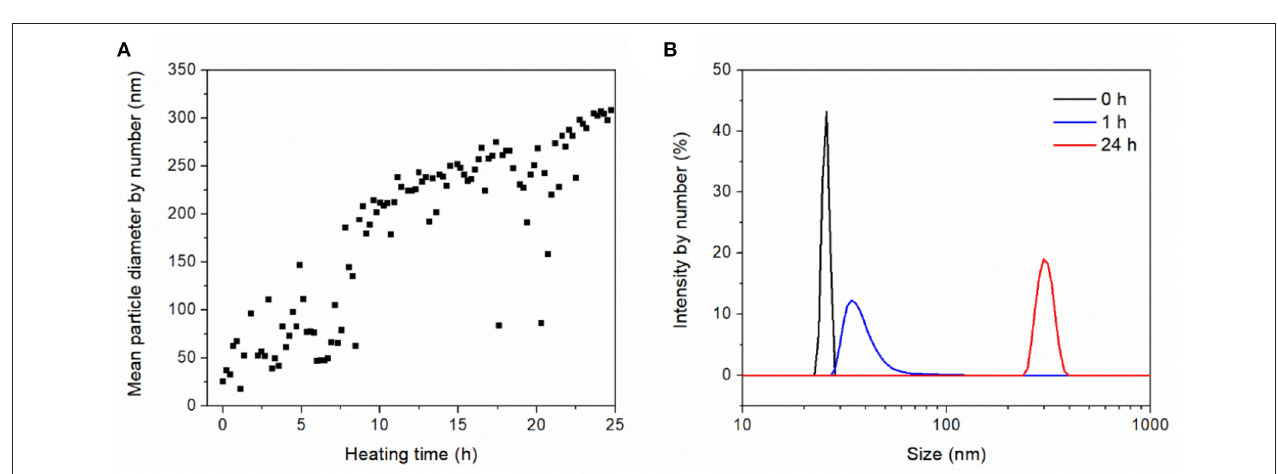
FIGURE 2 | Dynamic light scattering to characterize the heat-induced aggregation behavior of 1 g · L − 1 OVA dissolved in 0.1M NaCl (pH 6.9) and heated in a quartz glass cuvette at 72 ◦ C for 25h. (A) Aggregation kinetics. (B) Size distribution after heating for 0, 1, and 24h.